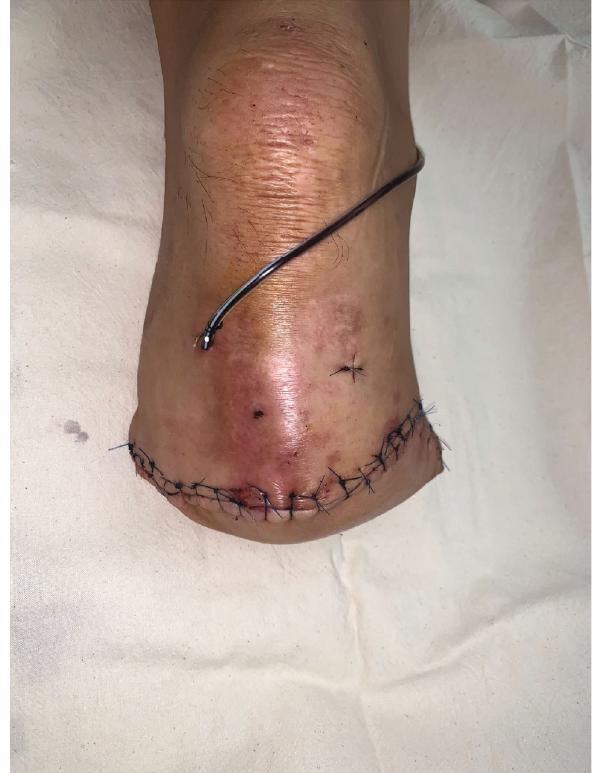
Figure 4: Postoperative photograph of the right lower